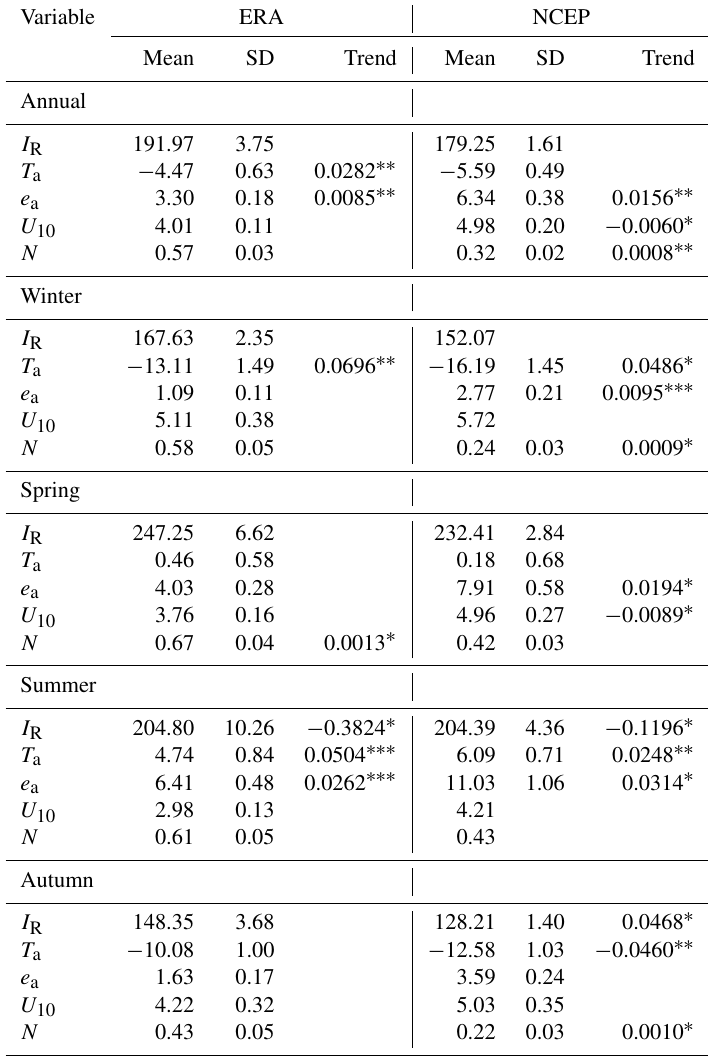
Table 3. A comparison of the meteorological variables in the ERA and NCEP reanalysis datasets. I R : incoming solar radiation [Wm − 2 ], T a